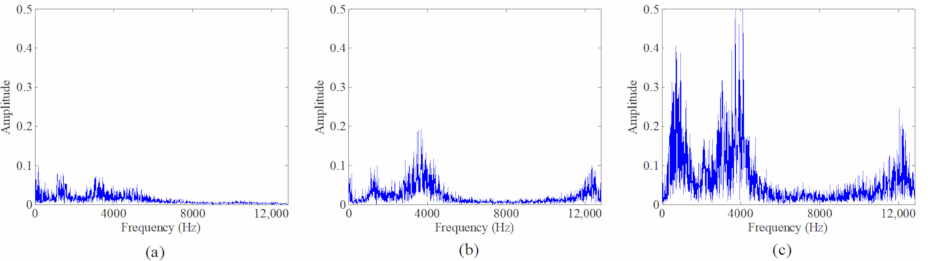
Figure 4. Spectrum images of bearing 4 in three operation stages: ( a ) Status 1, ( b ) Status 2, and ( c ) Status 3.